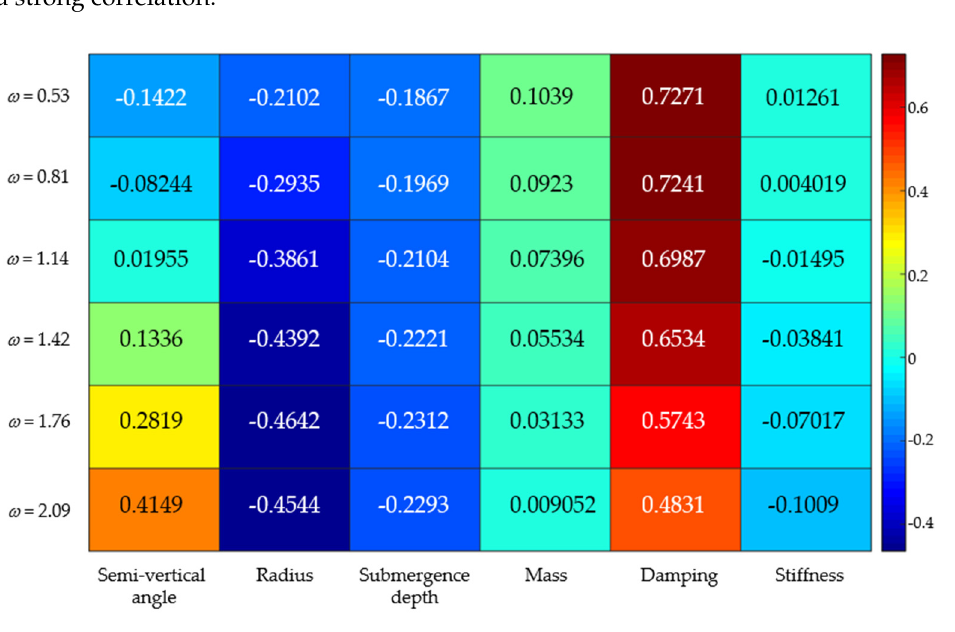
Figure 2. Sample scatter diagrams. ( a ) semi-vertical angle; ( b ) radius; ( c ) submergence depth; ( d ) mass; ( e ) damping; ( f ) stiffness.